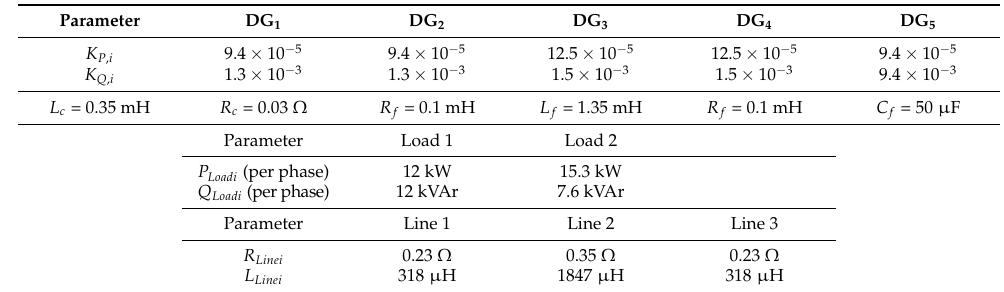
Table 1. Parameters of the AC